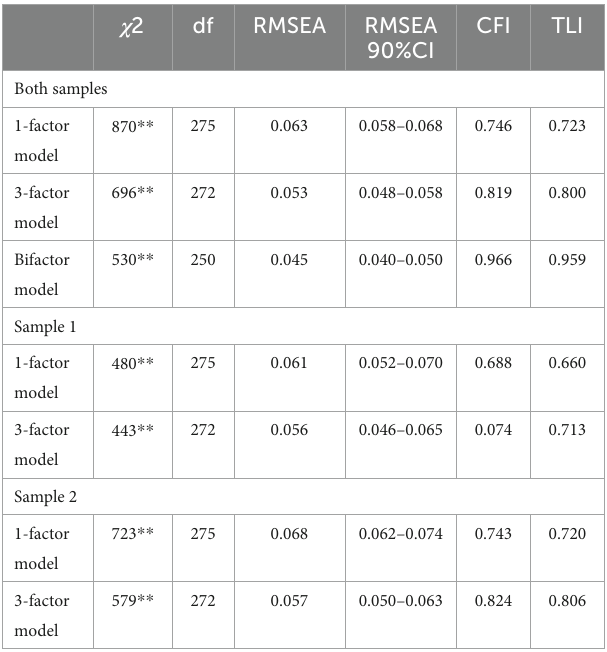
TABLE 2 Comparison of different models of the Czech DS-R using a confirmatory factor